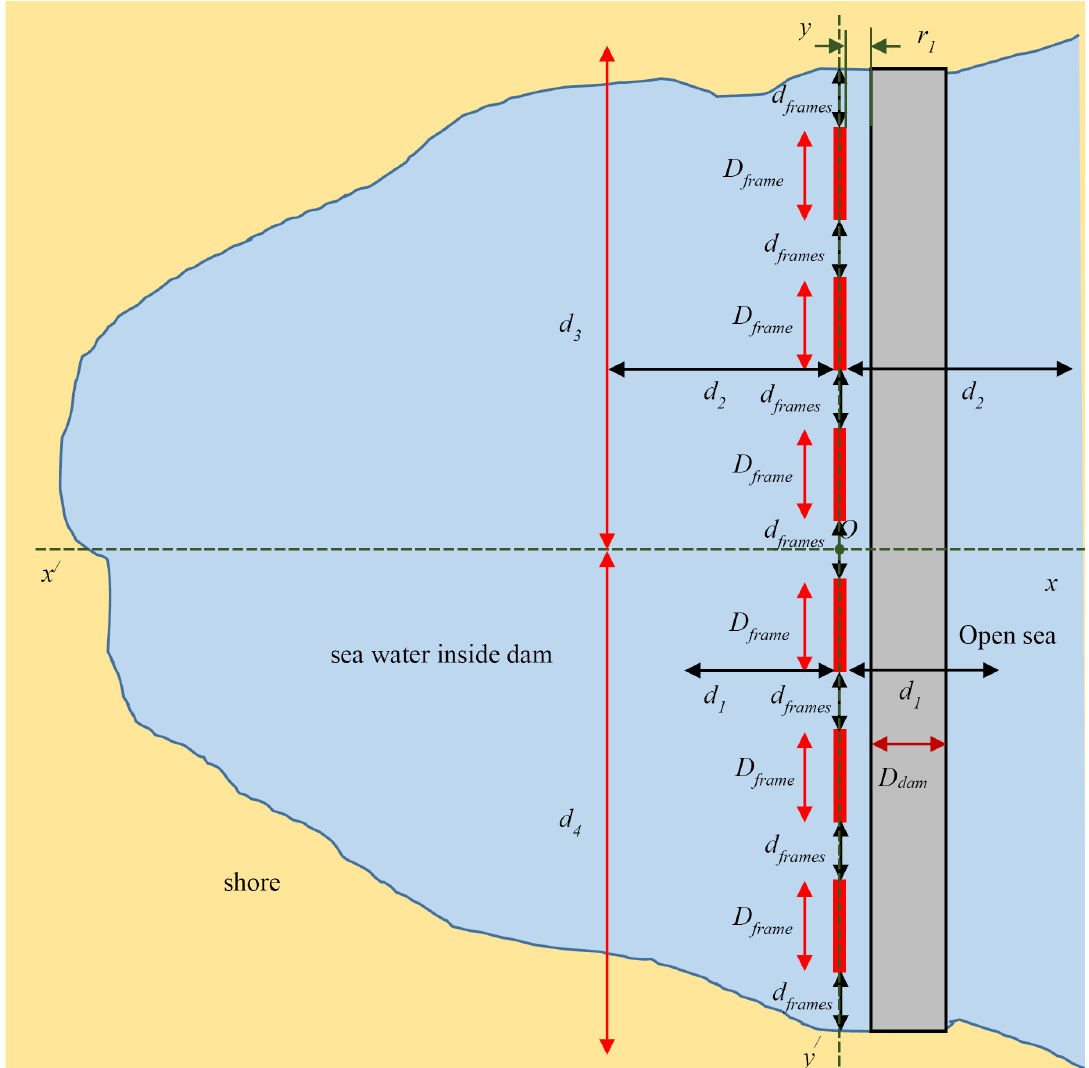
Figure 8. Indicative floor plan of six frames in a row, each frame parallel to the axis of the protective